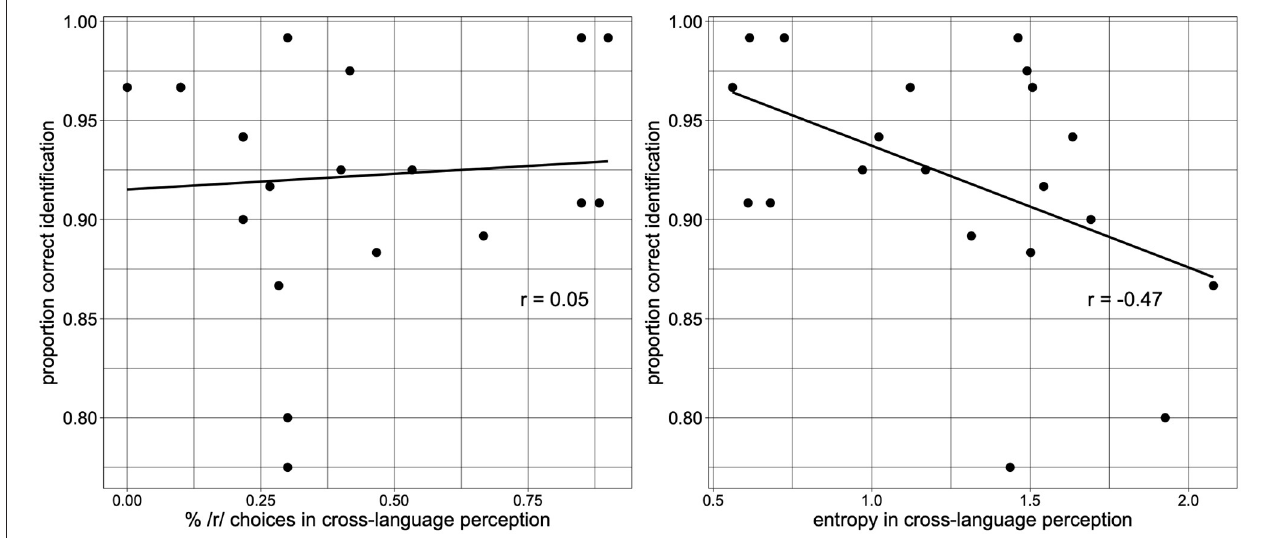
FIGURE 3 | Correlation between proportion correct identification for [ K ] and two measures of the cross-language perception task: % choices of the phonologically matching Spanish /r/ (Left) and entropy for [ K ] (Right)